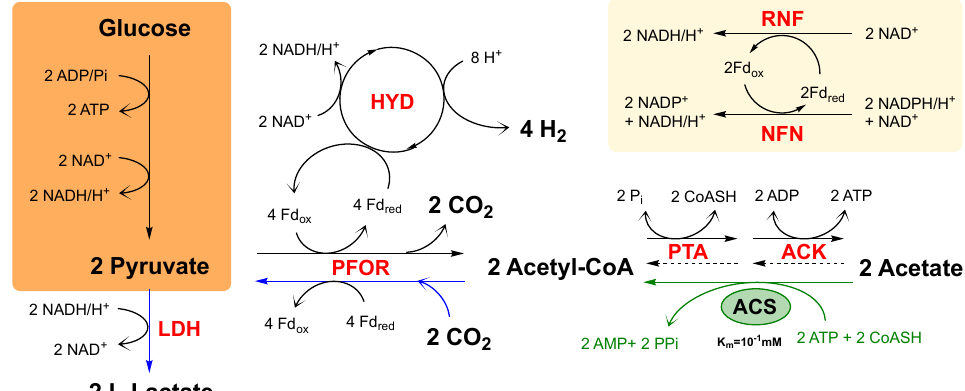
Figure 1. Schematic representation of the biochemical pathway underling the CLF process. Plain black arrows indicate the catabolic branch; blue arrows indicate the anabolic branch; green arrow indicates the ACS heterologous insertion. Boxes indicate glycolysis (orange) and putative NADH production by flavin-based oxido-reductase enzymes (pale yellow). ACK, acetate kinase; PTA, phosphotransacetylase; ACS, acetyl-CoA synthetase; PFOR, pyruvate:ferredoxin oxidoreductase; LDH, lactate dehydrogenase; HYD, hydrogenase; RNF, NAD-ferredoxin oxidoreductase; NFN, NADH-dependent reduced ferredoxin:NADP oxidoreductase; Fd, ferredoxin. Green arrow indicates the ACS heterologous insertion.